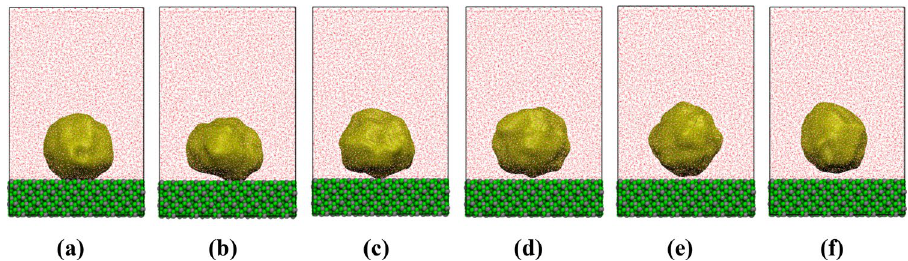
Figure 2. Time evolution of a vapor bubble on the zirconia (− 111) interface (frames a – f ). The vapor bubble was found to maintain the spherical shape across the trajectory. In ( b–d ) frames, a meniscus was created as expected in the macroscopic conceptualization of vapor bubble ( b ) and finally, the bubble detached from the interface (frames ( e,f )). In the latter frames, a non-evaporating thin water film was adsorbed on the zirconia interface (see also ( b )) due to the surface hydrophilicity. The snapshots correspond to simulation times of 0.05, 0.10, 0.15, 0.30, 0.35 and 0.40 ns respectively. Images were created using VMD v1.9.4 47